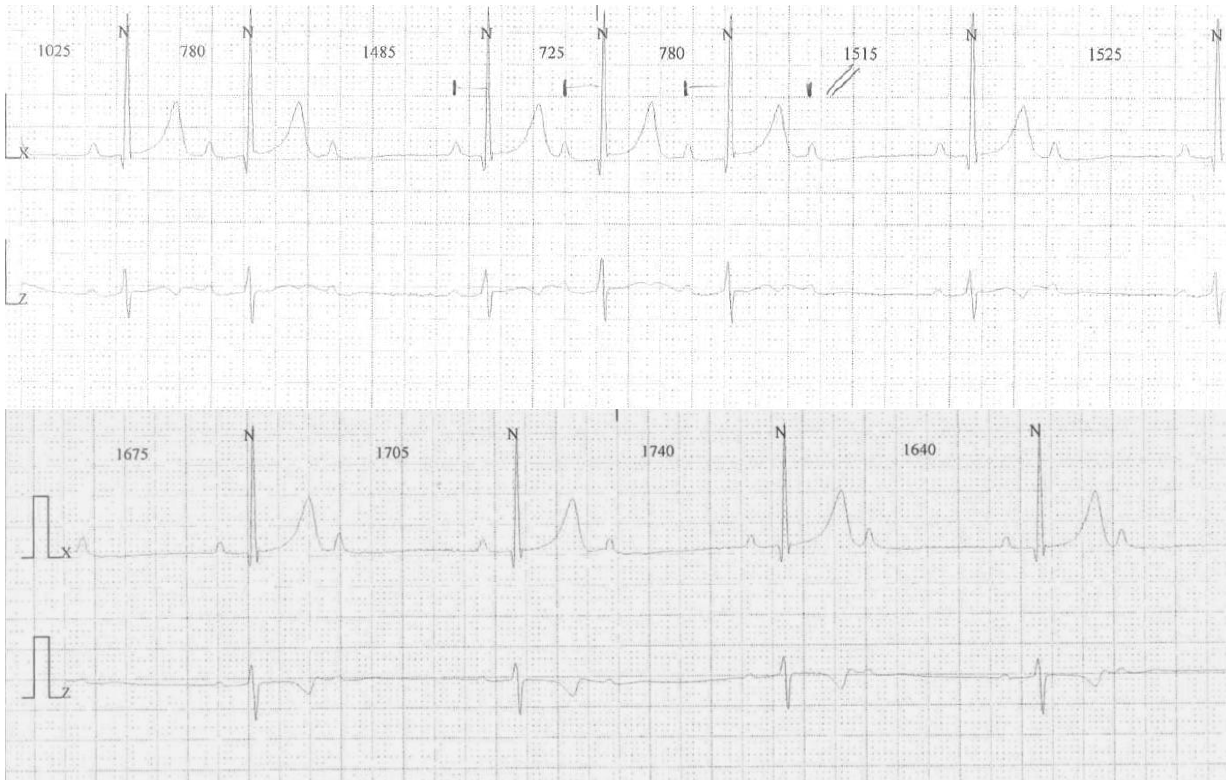
Figure 1. A 24h Holter monitoring (4 years) showing Mobitz type 1 atrio-ventricular block (AVB) (upper line) and 2:1 AVB (lower line).